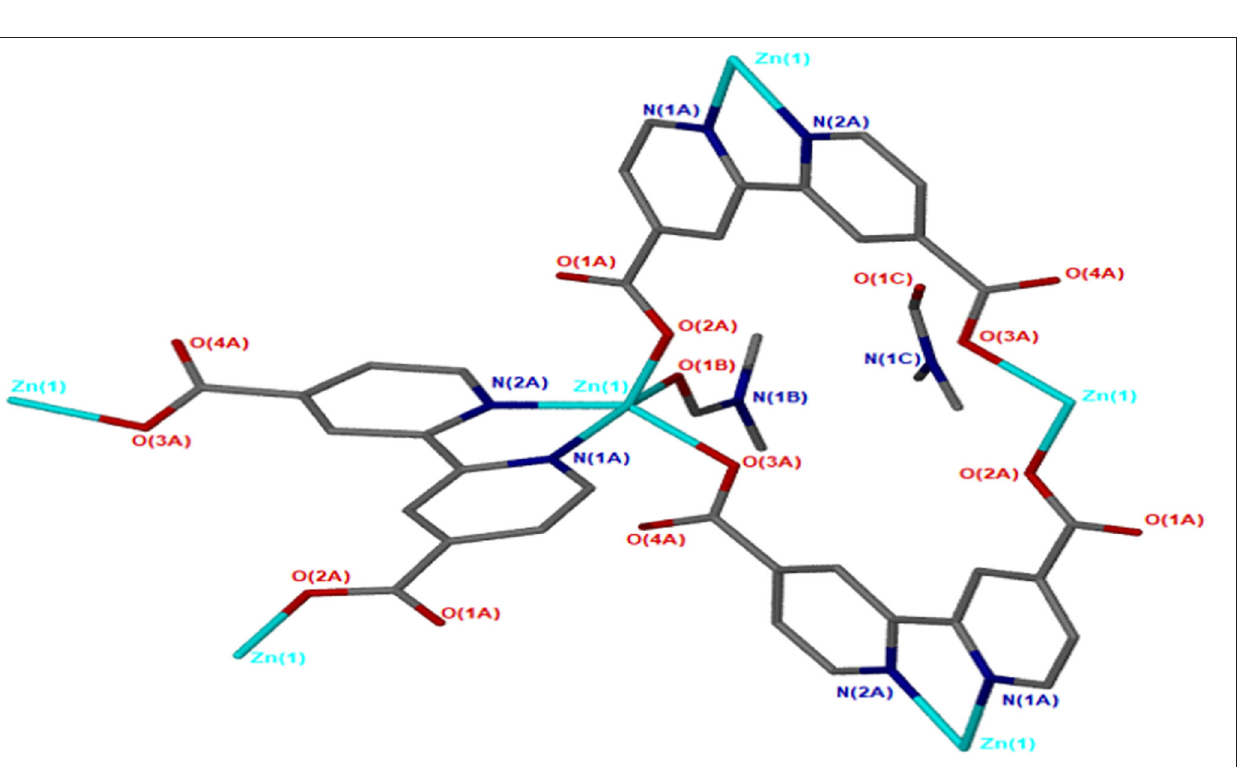
FIGURE 3 | Coordination geometry of Zn(II) in JMS-4.